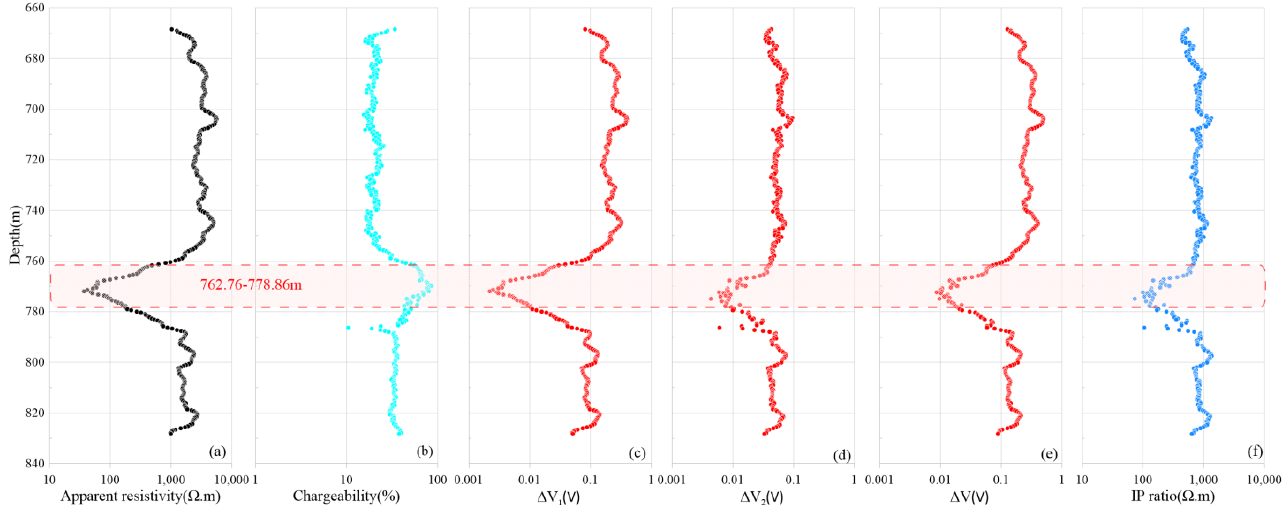
Figure 24. Logging curve of the induced polarization parameters observed using the borehole IP method (a) Apparent resistivity; ( b ) Chargeability; ( c ) Voltage of primary field; ( d ) Voltage of secondary field;( e ) Voltage of total field;( f ) IP ratio.